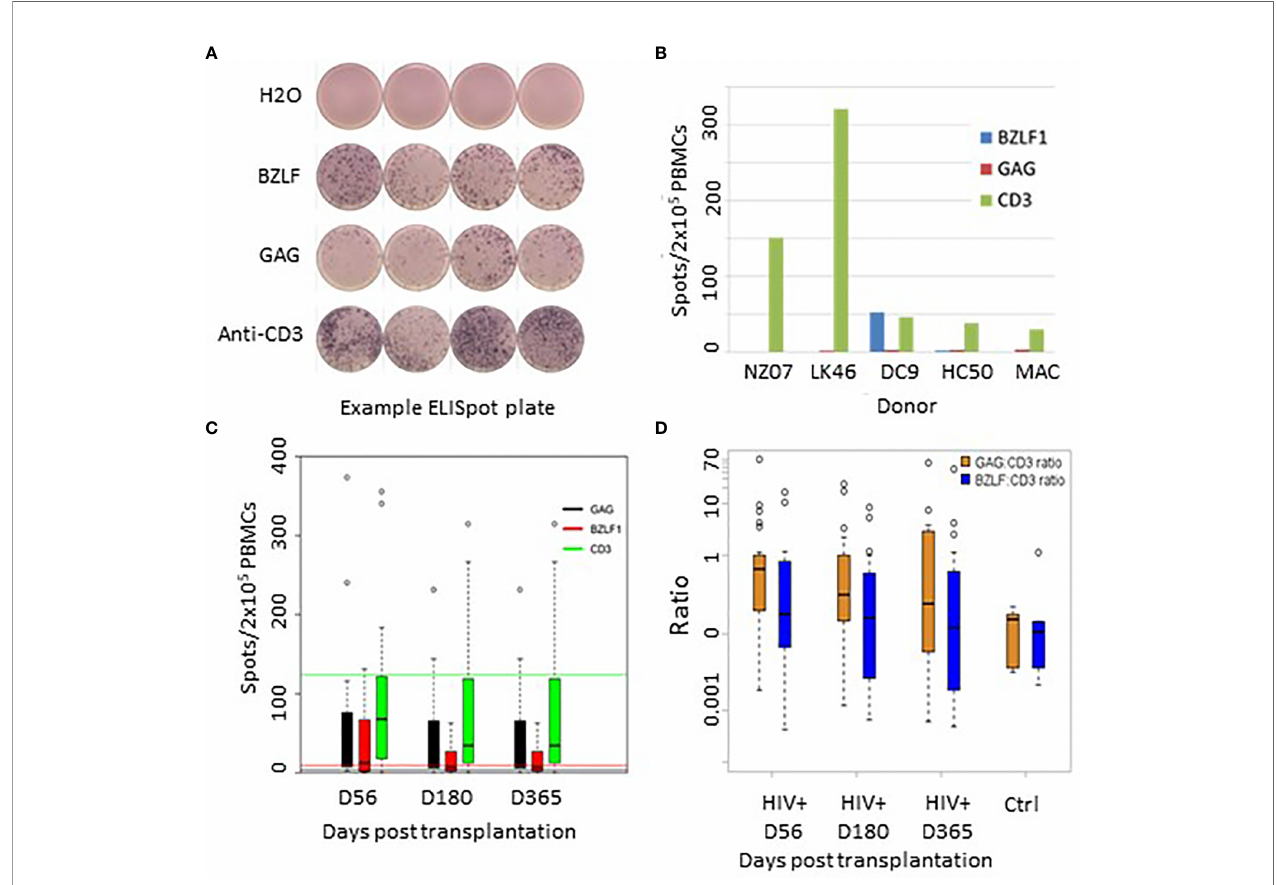
FIGURE 9 | (A) Representative Elispot plate raw data. (B) Recall antigen responses in 5 healthy EBV+/HIV- donors. (C) Recall responses to GAG, BZLF, and anti TCR post transplant. Green line = TCR mean response from healthy donors; Red line = BZLF1 mean responses from healthy controls; Black line = background GAG responses from healthy controls. (D) Recall response ratios controlled for responsiveness to TCR stimulation with CD3-directed